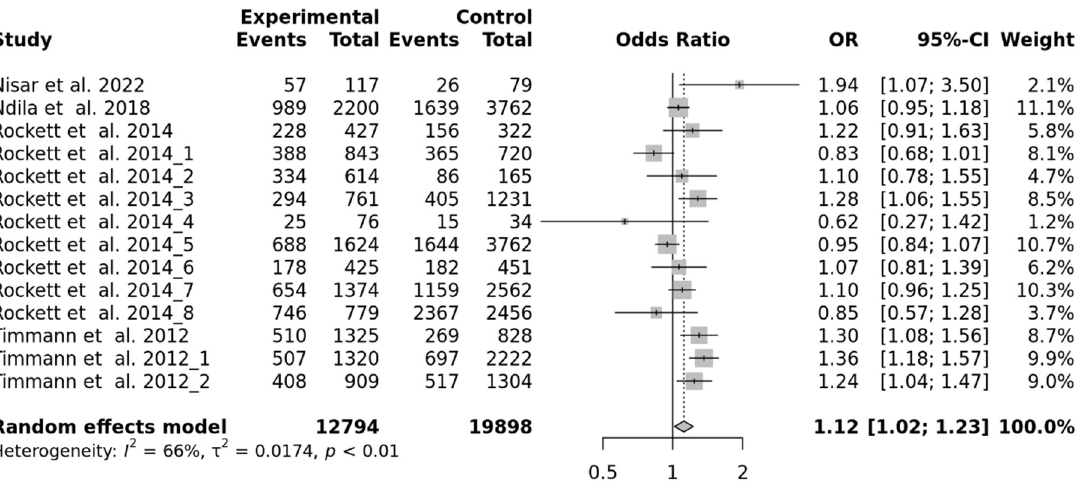
Figure 3. Forest plot displaying meta-analysis for the association between rs10900585 and SM.